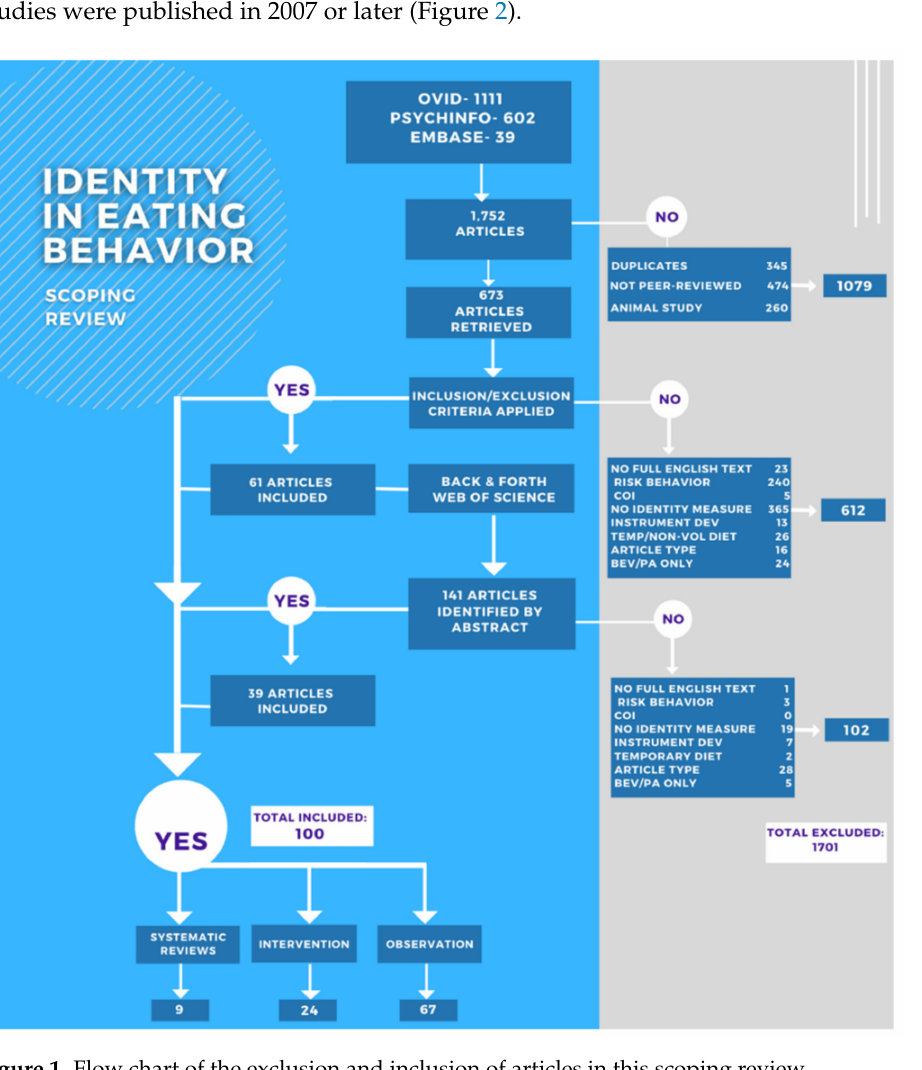
Figure 1. Flow chart of the exclusion and inclusion of articles in this scoping